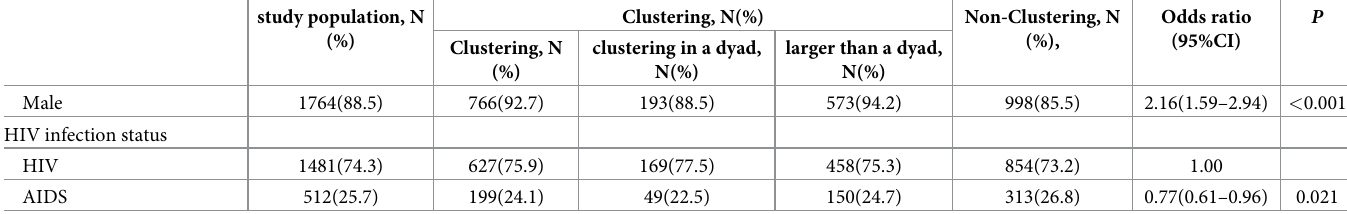
by heterosexual contact (n = 796, 39.9%). Most individuals (n = 1,701, 85.3%) lived in Zhejiang province at the time of diagnosis. 48.5% (569/1173) of MSM were diagnosed in Hangzhou city, which was higher than the proportion of non-MSM (235/820; X 2 = 76.730, P < 0.01) diagnosed in the same city. Further, 92.4% (207/224) of students were MSM, a higher percentage than that of other populations ( X 2 = 117.338, P < 0.001). The majority of subjects were unmarried (55.5%, 1106/1993), while 11 pairs of infected individuals in this study were spouses. Transmission network analysis The 1,993 sequences were classified into 10 subtypes, with the main subtypes being CRF01_AE (51.5%, 1025/1993) and CRF07_BC (37.6%, 749/1993), followed by CRF08_BC (5.5%, 110/ 1993), B (3.9%, 78/1993), C (0.9%, 17/1993), CRF03_AB (0.3%, 6/1993), CRF02_AG (0.1%, 2/ 1993), CRF04_CPX (0.1%, 2/1993), A (0.05%, 1/1993), and CRF18_CPX (0.05%, 1/1993) (See Fig 1 for phylogenetic trees). The mean GDs within CRF01_AE and CRF07_BC in the popula- tion were 0.047 ± 0.012 and 0.028 ± 0.010 substitutions per site, respectively. The curves of HIV transmission cluster amounts and maximum cluster sizes with a range of GDs (0.1–2.0%) among subtypes CRF01_AE, CRF07_BC, and B were plotted (Fig 2). Among 78 subtype B sequences, a maximum of eight clusters were identified with cluster sizes ranging from two (n = 3 dyads) to six sequences, and the plausible GD threshold was 1.7% (Fig 2C). Among subtype CRF01_AE sequences, 114 clusters were identified with cluster sizes ranging from 2 (n = 58 dyads) to 52 sequences and an optimal GD threshold of 1.2% (Fig 2A). In the CRF07_BC network, a maximum 66 clusters were identified, with cluster sizes ranging from 2 (n = 44 dyads) to 80 sequences, yielding an optimal GD threshold of 0.5% (Fig 2B). The clustering rates for CRF01_AE, CRF07_BC, B, CRF08_BC, and C were 50.9% (523/ 1027), 34.2% (256/749), 14.5% (16/110), 32.1% (25/78), and 35.3%(6/17), respectively. The median cluster sizes of these subtypes were 2 (2–52, n = 523), 2 (2–80, n = 256), 3 (2–6, n = 25), 2 (2–6, n = 16), and 6 (n = 6), respectively. Using the selected GD threshold, 826 indi- viduals were linked with at least one other individual, giving a total of 1,305 edges (Fig 3A). Eleven pairs of spouses were identified among the clusters. All appeared in the same cluster with their spouses, and 63.6% (14/22) of them formed dyads. Individuals over 50 years of age made up 68.2% (15/22) of the spousal pairs. The infection routes for 11 women was heterosex- ual transmission. Nine of eleven male cases were infected via heterosexual behavior, one was infected via sexual encounter with other men, and the last was infected via injection drug use. Large size clusters The largest cluster sizes in subtypes CRF07_BC, CRF01_AE, and B contained 80, 52, and 6 individuals, respectively. In these clusters, the proportions of gay men were 80%